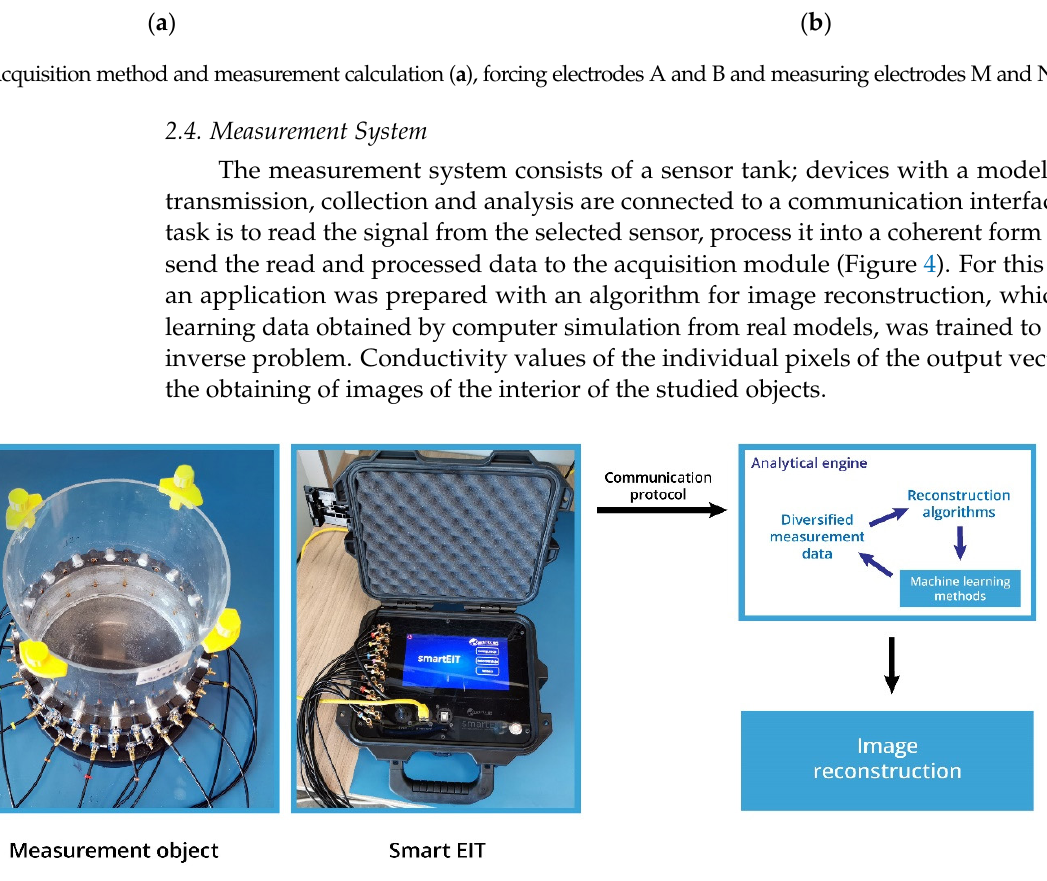
Figure 4. Measurement system with a model of data transmission, collection and analysis.